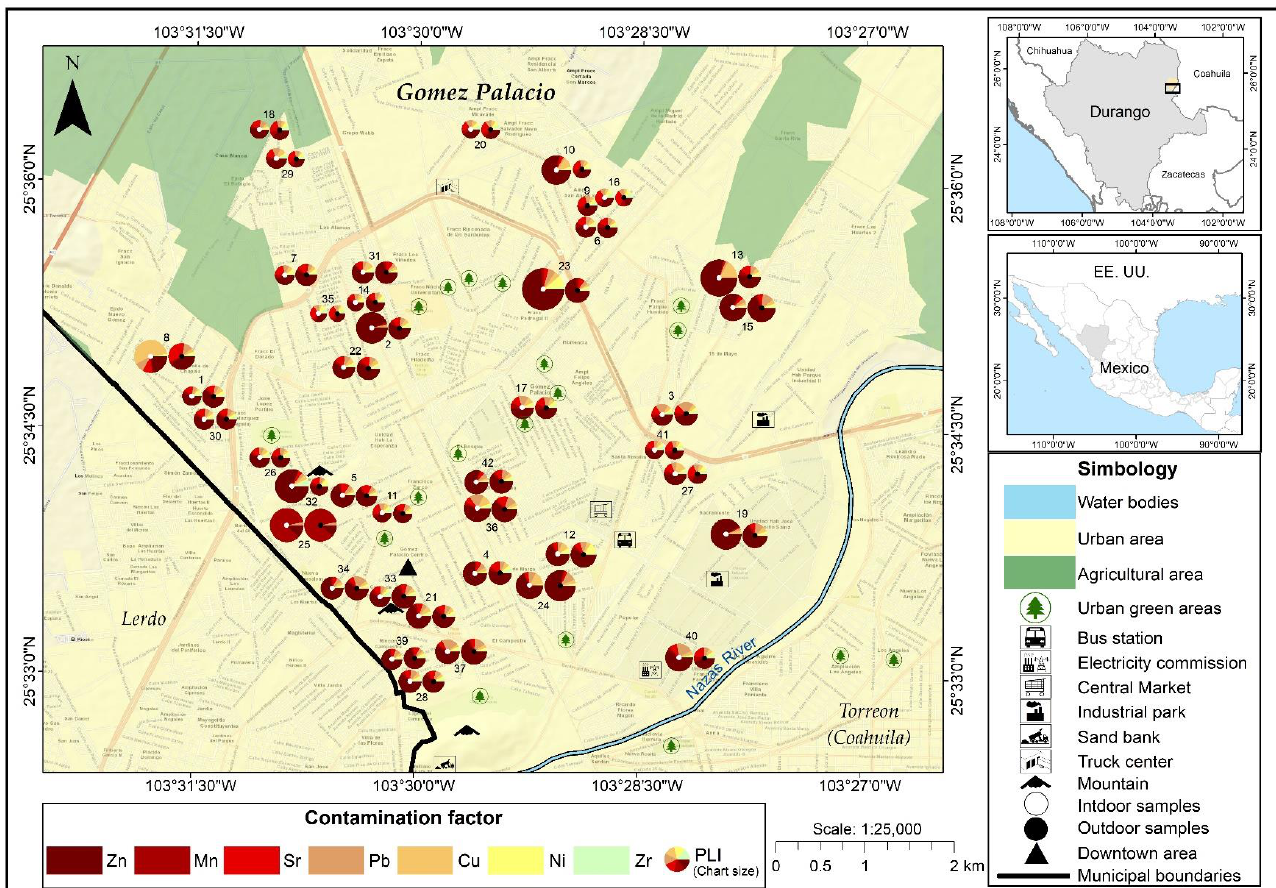
Figure 6. Pollution factor and PLI by sampling site indoors and